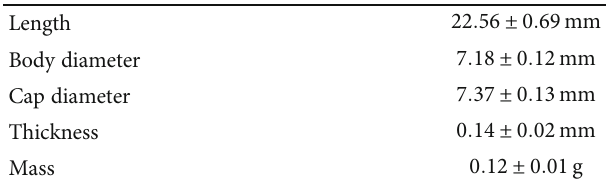
Table 1: Dimension and mass of CRG-MD/SOR (carrageenan- maltodextrin/sorbitol) hard-shell